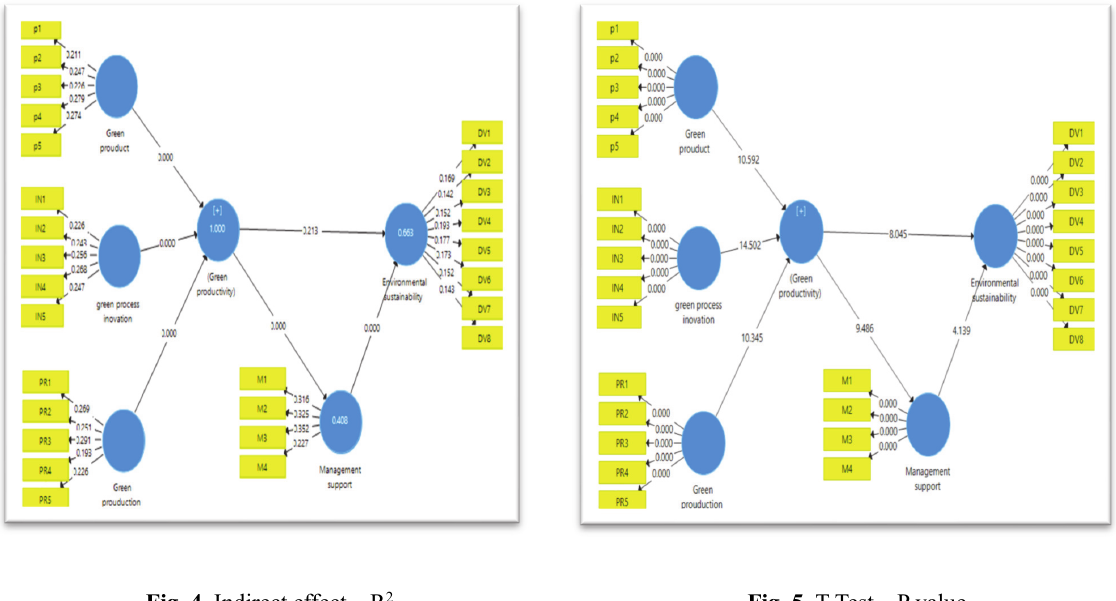
Fig. 4. Indirect effect – R 2 Fig. 5. T Test – P